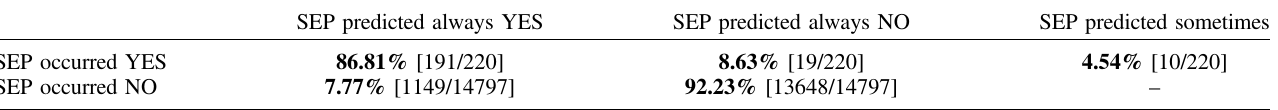
Fig. 5. Flare-SEP samples with the numbers of their correct predictions in the k = 10 cross-validation process. Table 2. Results from the k -fold validation